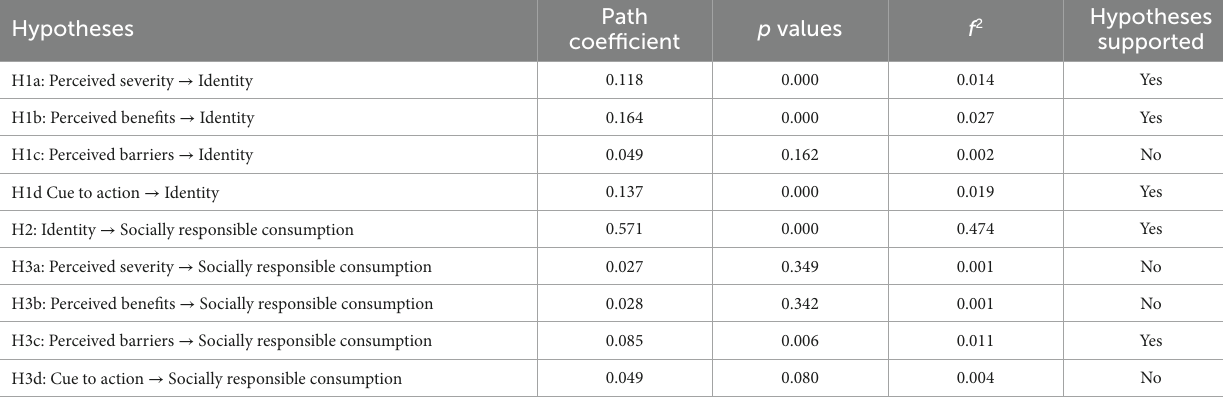
TABLE 7 Results of the structural model